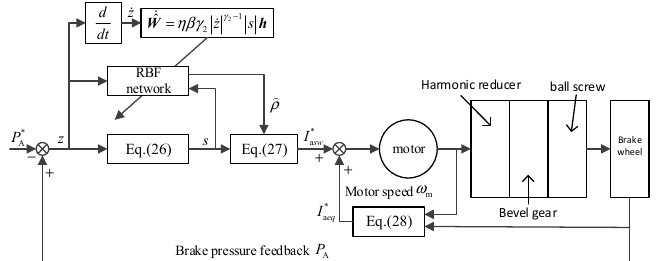
Figure 3. Structure of the EMA sliding mode control based on RBF.